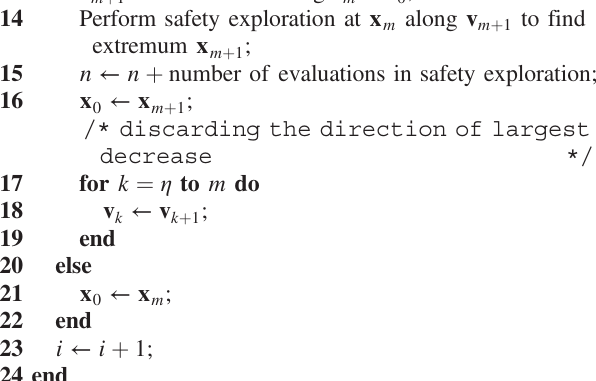
FIG. 5. Snapshot of the safety probability along the parameter range at the end of 1D safety exploration. The safety probability curve is calculated based on the Gaussian random walk drift model with the previous observations (orange triangles). The order of sampling is denoted by the number on top of each observation. The blue curve is the calculated safety probability and the green shaded area shows the safety region, with the safety ¼ 0 . 9 . probability threshold p s